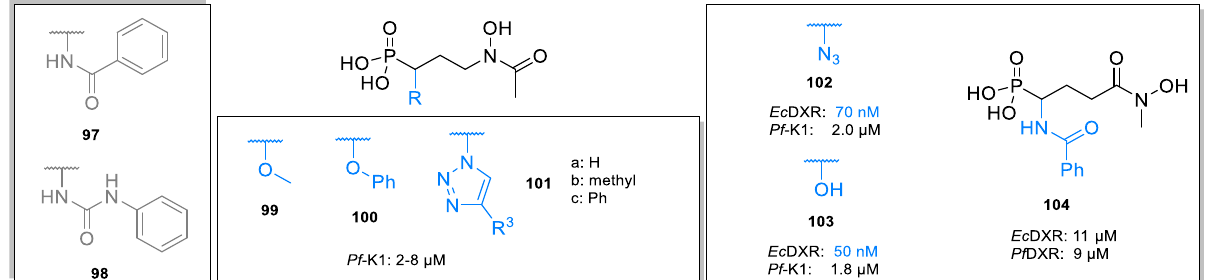
Figure 21. Biological data of structurally diverse α -substituted analogs 97 – 104 .